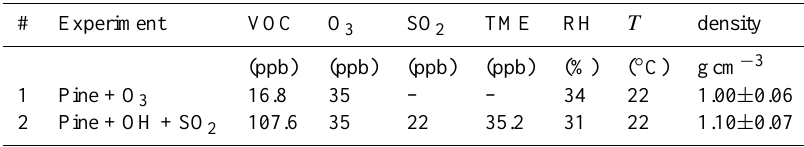
Table 1. Summary of plant chamber experiments. Values are determined at the beginning of trials (density during experiments ± standard